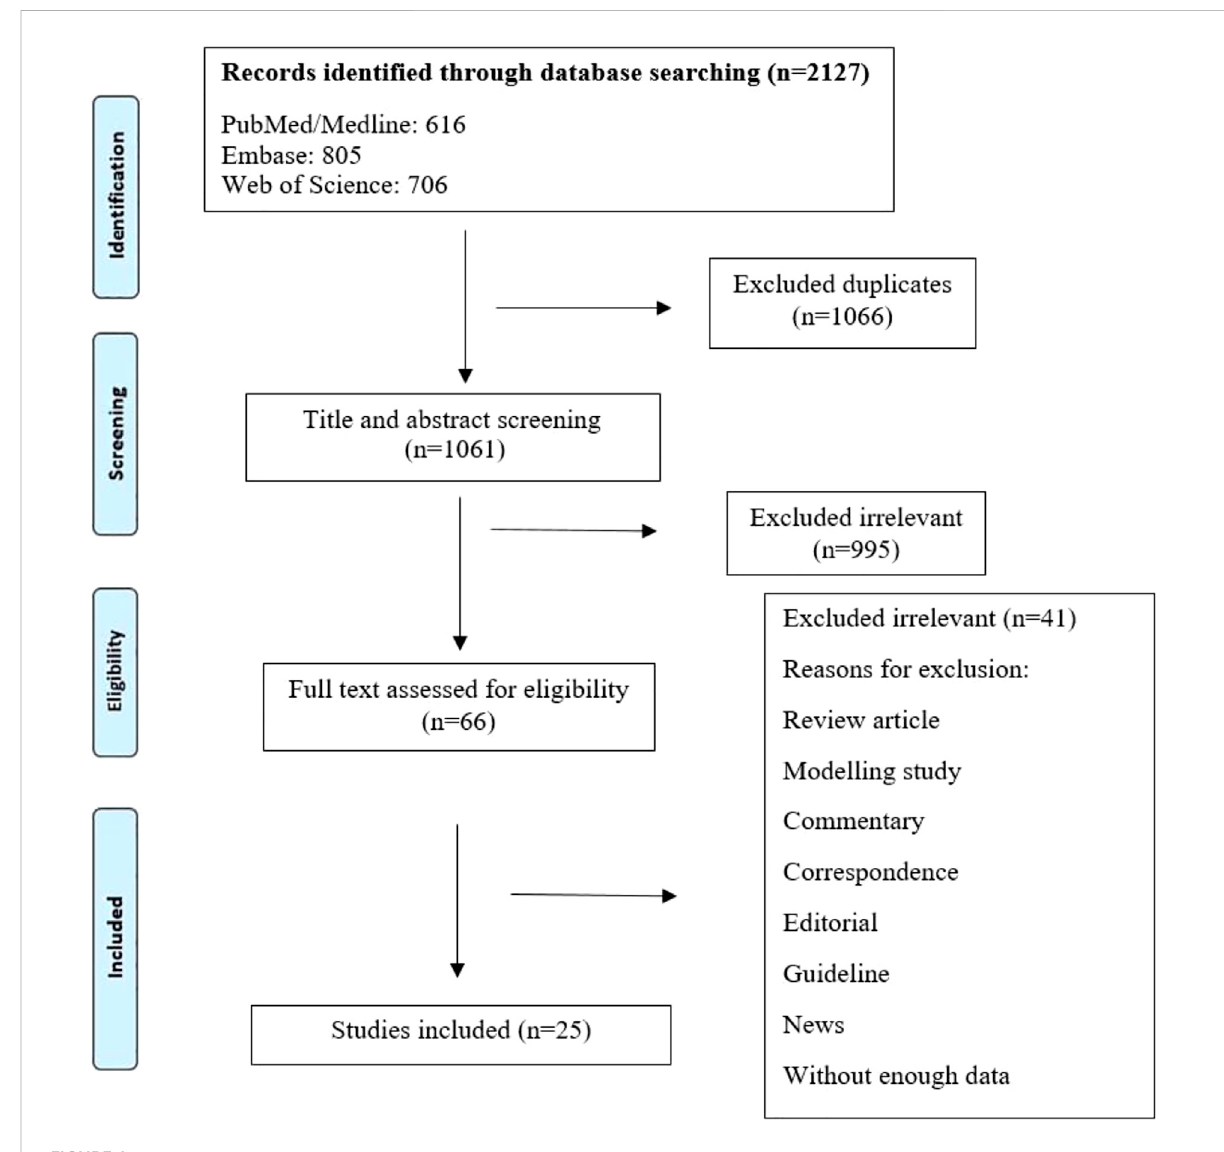
Flow diagram detailing review process and study